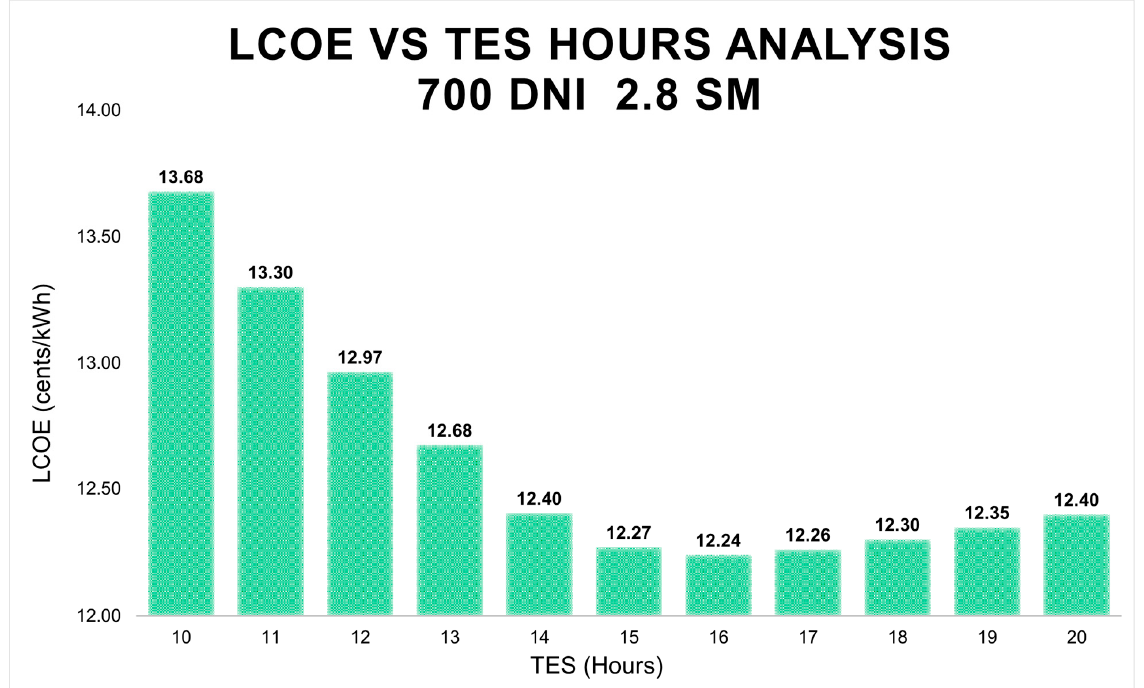
Figure 11. Optimization for 700 DNI and 2.8 SM.